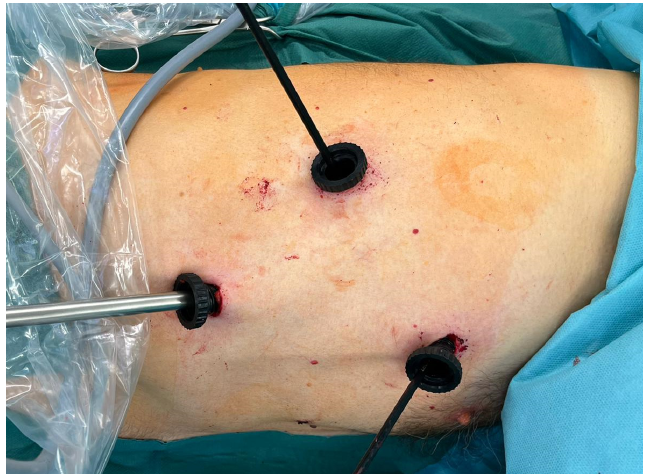
Figure 1. Trocar placement during 3P-VATS.